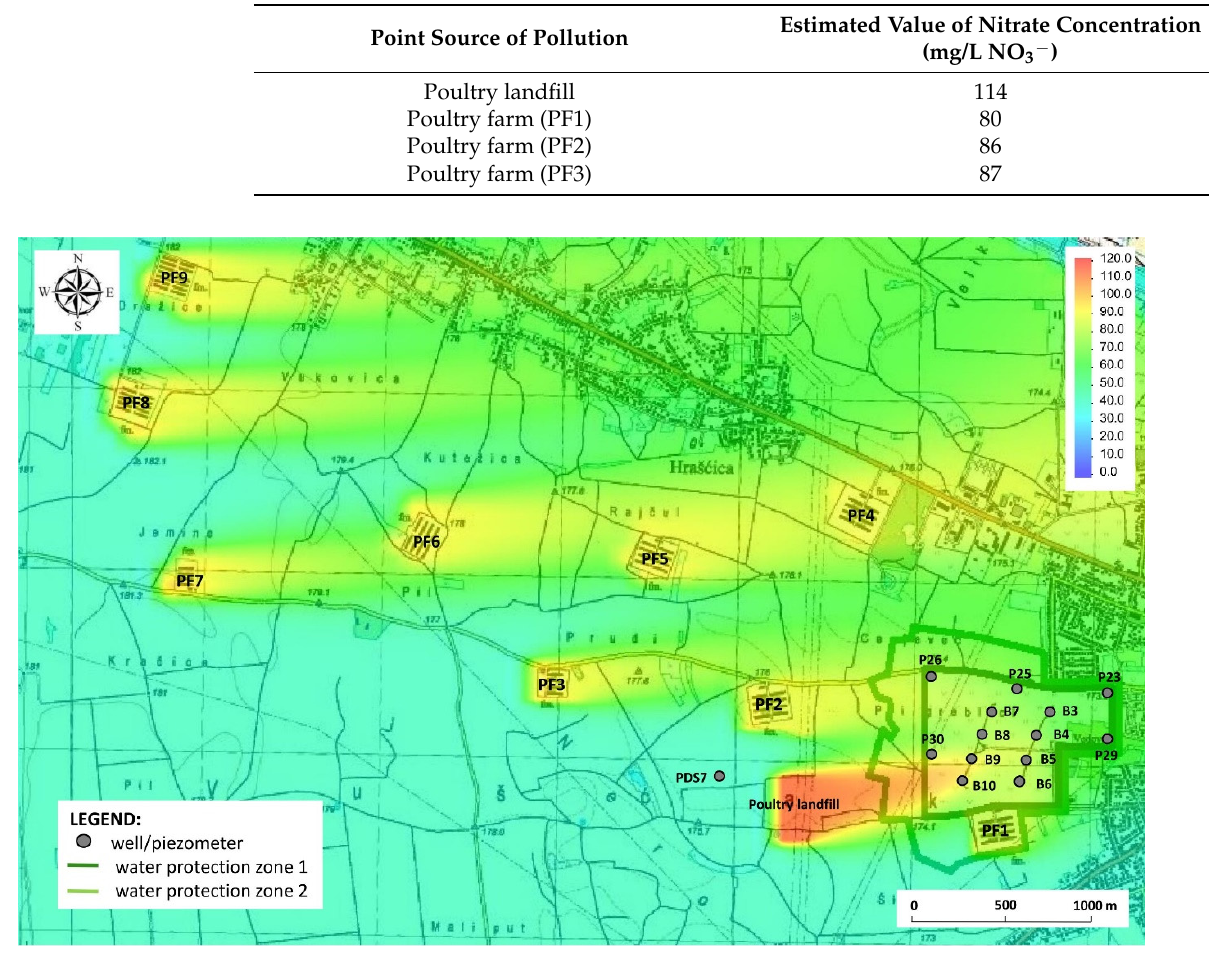
Figure 7. Nitrate pollution propagation.